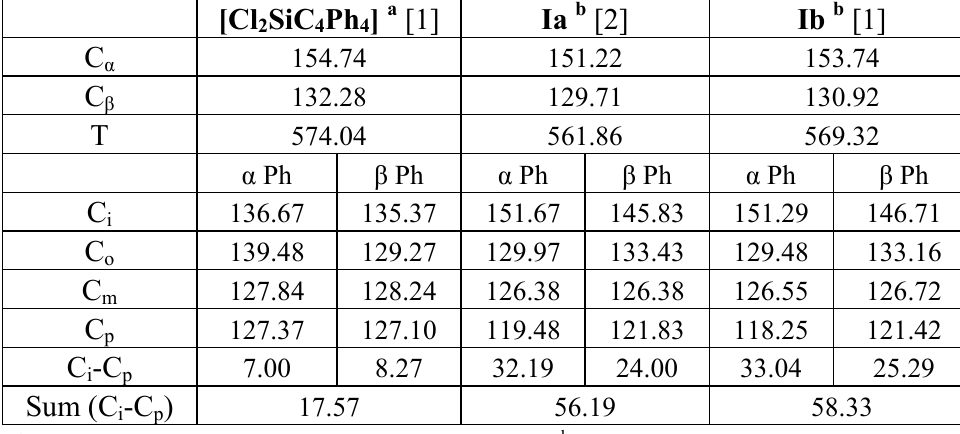
Table 4. 13 C-NMR chemical